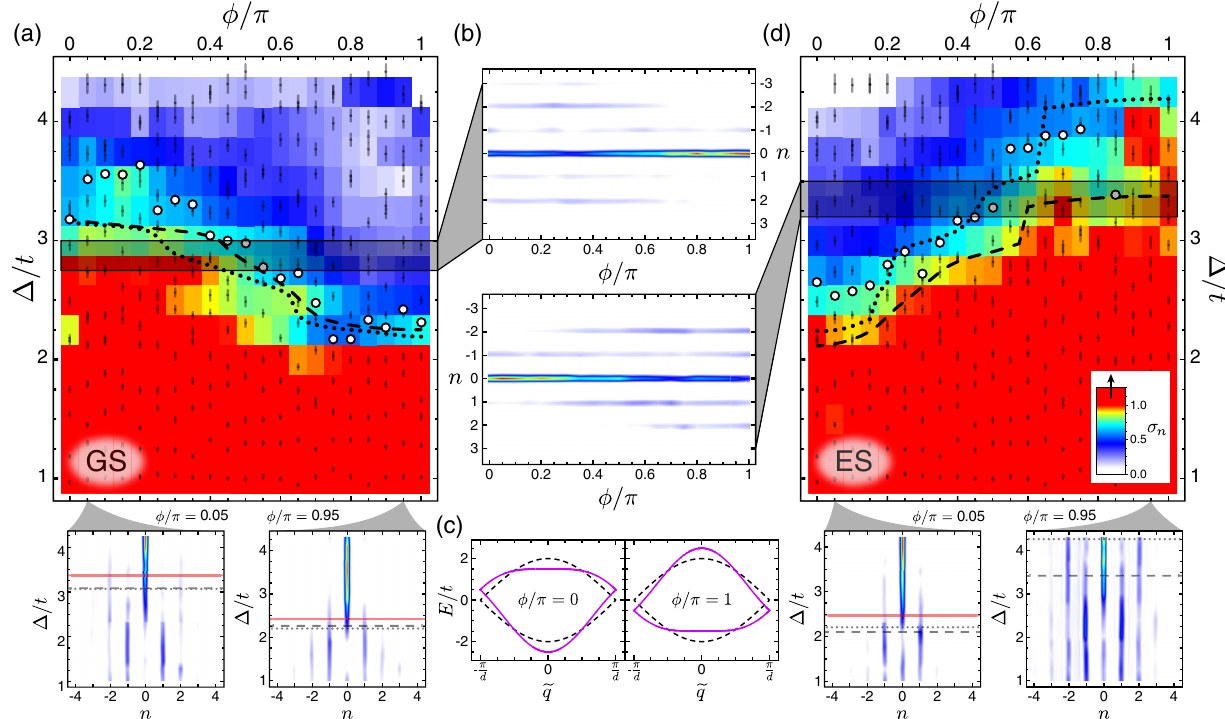
FIG. 4. Flux-dependent localization transition in the AA model with multirange tunneling. (a) Top: Ground state (GS) localization behavior for varying values of disorder Δ =t and flux ϕ = π , in a zigzag lattice with NN tunneling t= ℏ ¼ 493 ð 2 Þ Hz and NN to NNN tunneling ratio t 0 =t ¼ 0 . 247 ð 4 Þ . Colors indicate the width (standard deviation) of the site population distribution σ n [inset color scale in (d)], interpolated from the sampled data points (small solid black circles). The empirically determined transition disorder strength between delocalized and localized regions is shown for the data (white circles), a noninteracting simulation of the experiment (dashed black line), and a simulation including attractive interactions of strength U= ℏ ≈ 2 π × 500 Hz (dotted black line). Bottom: Localization properties as visualized by the integrated 1D density patterns for roughly 0 and π flux. The 1D atomic distributions are interpolated from integrated OD images for ϕ = π ¼ 0 . 05 (left) and 0.95 (right), shown as a function of Δ =t . Horizontal lines show the empirically determined localization transition point for data (solid red), noninteracting simulation (dashed gray), and simulation including interactions (dotted gray). (b) Cuts as a function of ϕ showing site populations interpolated from integrated OD images, shown for the GS (top) and the highest excited state (ES, bottom). These integrated OD plots are averaged from data taken in the ranges 2 . 75 ≤ Δ =t ≤ 3 and 3 . 2 ≤ Δ =t ≤ 3 . 5 , respectively, as indicated by the shaded regions. (c) Band structure diagrams for the zigzag lattice with applied flux ϕ = π ¼ 0 (left) and ϕ = π ¼ 1 (right). As in Fig. 2(a), color represents spin polarization. Dashed black curves represent the folded band structure for t 0 =t ¼ 0 . (d) ES localization behavior for varying disorder and flux values, with the same format as in (a). Bottom: Localization properties of the ES as a function of Δ =t , also with the same format as in (a). Error bars in (a) and (d) denote 1 standard error of the mean. OD images in (a), (b), and (d) are plotted with the color scale in Fig.